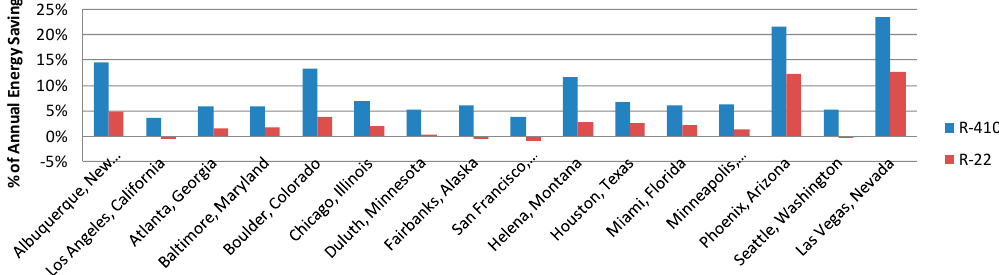
Figure 7. Annual energy savings for a medium office (present) building with two-speed unit and WB efficiency fixed at 0.7 in all 16 climate zones.